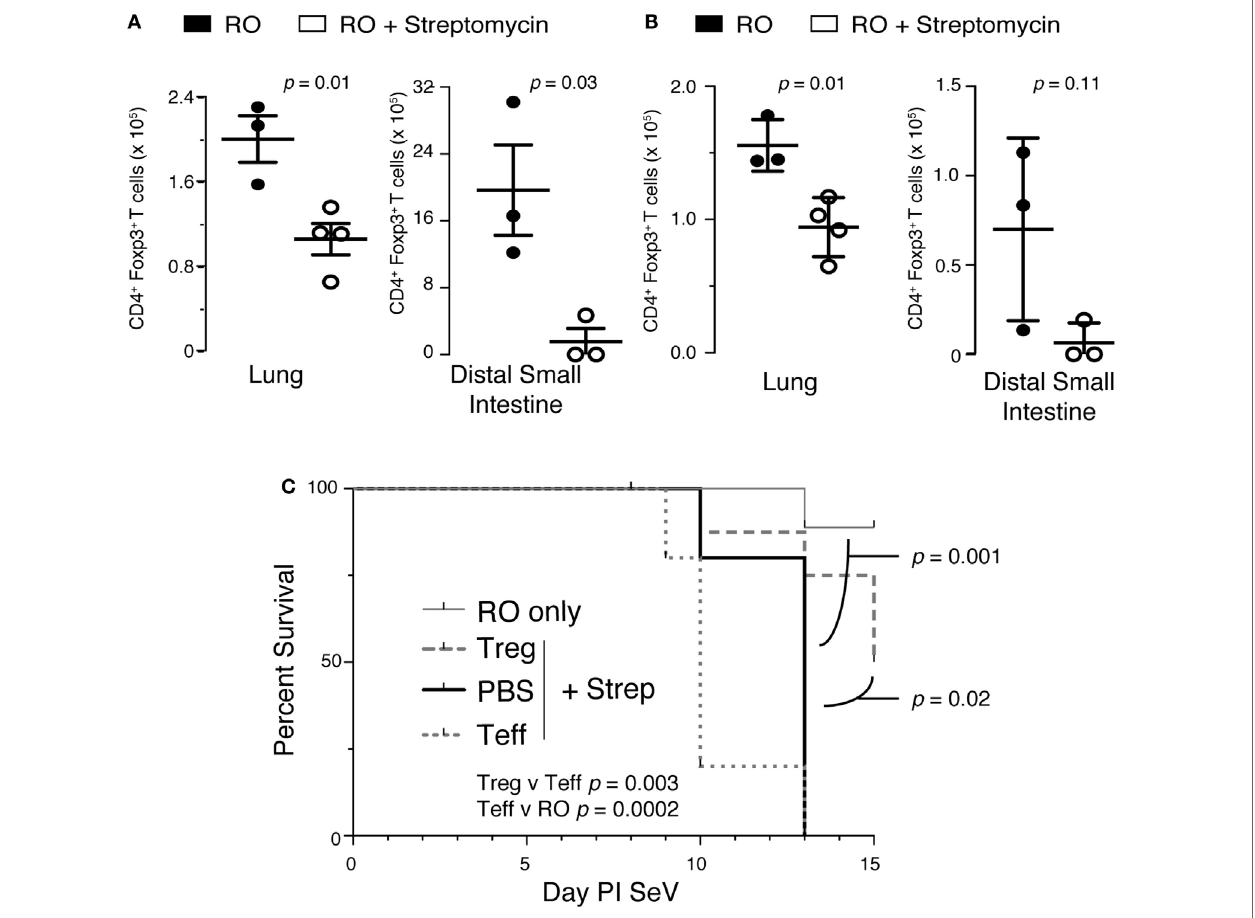
FigUre 7 | Disruption of intestinal microbiota reduces lung and intestinal regulatory T cells (Tregs), which are needed to prevent increased mortality to Sendai virus (SeV). (a) Foxp3 + Tregs isolated from the lung or distal small intestine from mice treated with 2 weeks of reverse osmosis (RO) or RO + streptomycin ( n = 3–5 mice/ group). (B) Mice treated as in panel (a) but after 2 weeks of RO or RO + streptomycin water the mice were infected with SeV and number of Foxp3 + Tregs determined at day 8 PI SeV ( n = 3–4 mice/group). (c) Adoptive transfer of CD4 + /Foxp3 + Treg but not CD4 + /Foxp3 − effector T (Teff) cells at the time of SeV infection prevents the increased mortality seen in mice given 2 weeks of streptomycin before viral infection. RO only = mice given RO water and infected with SeV without any transfer of cells; Treg + Strep, PBS + Strep, and Teff + Strep are mice given 2 weeks of streptomycin followed by adoptive transfer of the given cells and SeV inoculation ( n ≥ 5 mice/group, data combined from two separate